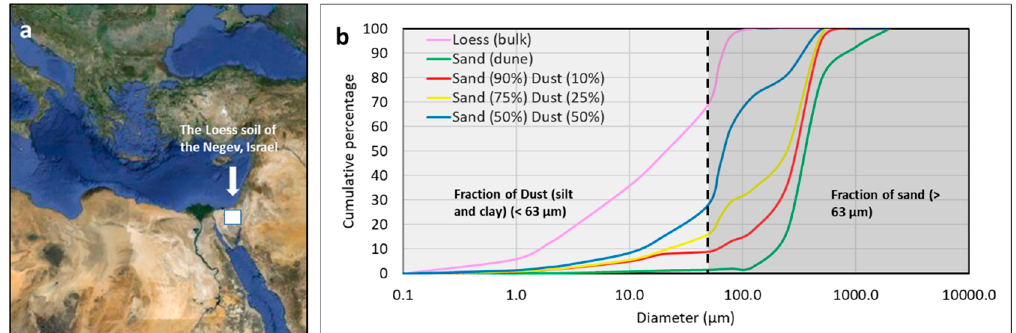
Figure 1. ( a ) Location of the loess soil in the Negev (Israel), Eastern Mediterranean. ( b ) Particle size distribution of the soil samples used for the experiments: sand dune and various mixes of sand and dust fractions that were used for the wind tunnel experiment. The dust fraction, which used for the preparation the mixed samples, was extracted from a loess (bulk) soil.